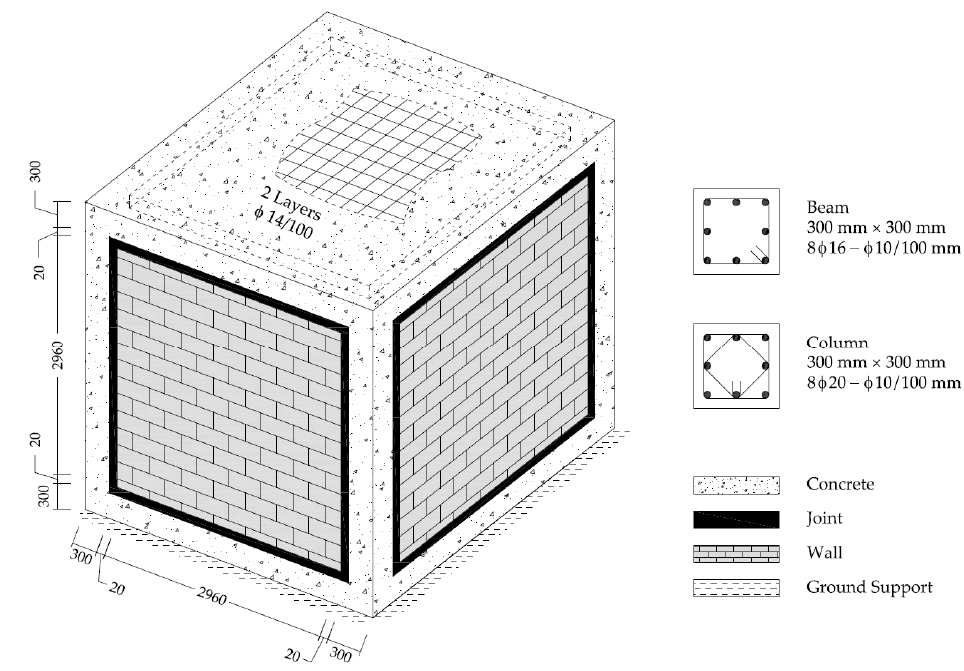
Figure 3. Schematic view of the large size buildings [mm].